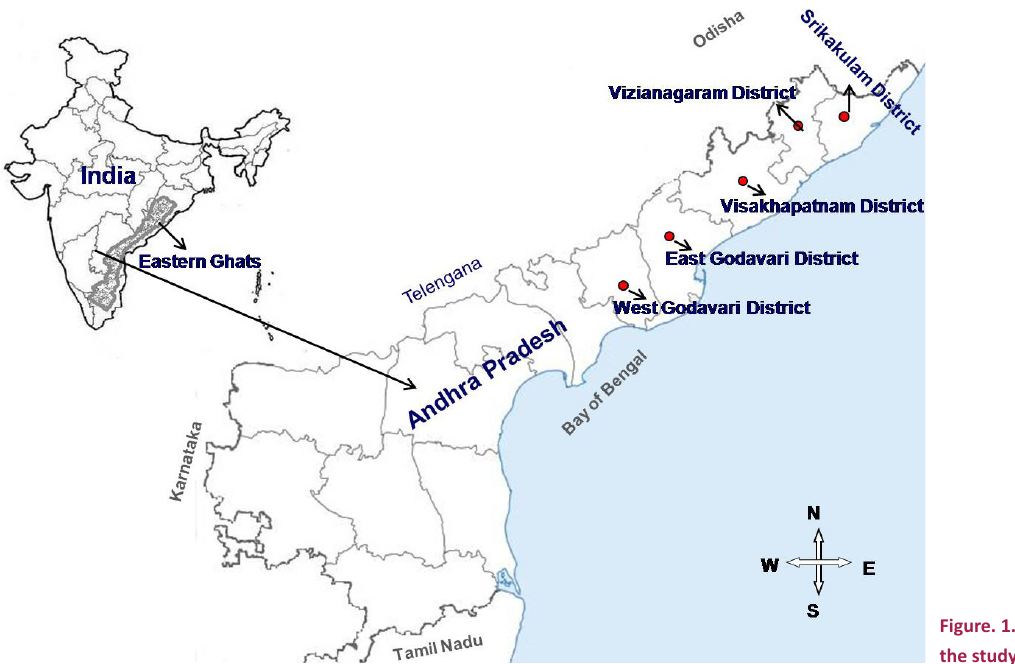
Figure. 1. Location map of the study